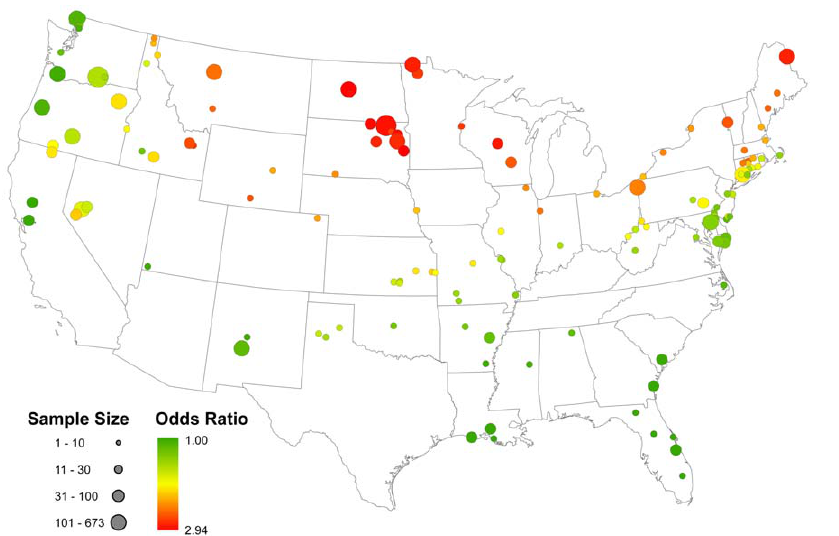
Figure 3. Map showing the odds ratio for the overwintering season temperature effect from the top model fit to the data. The sample size reflects the number of AIV samples collected within each of the 137 local watersheds used in this analysis and the colors reflect the mean odds ratio of testing positive for AIV, with red indicating that the odds of testing positive for AIV are nearly three times as likely than points colored dark green based on this variable.